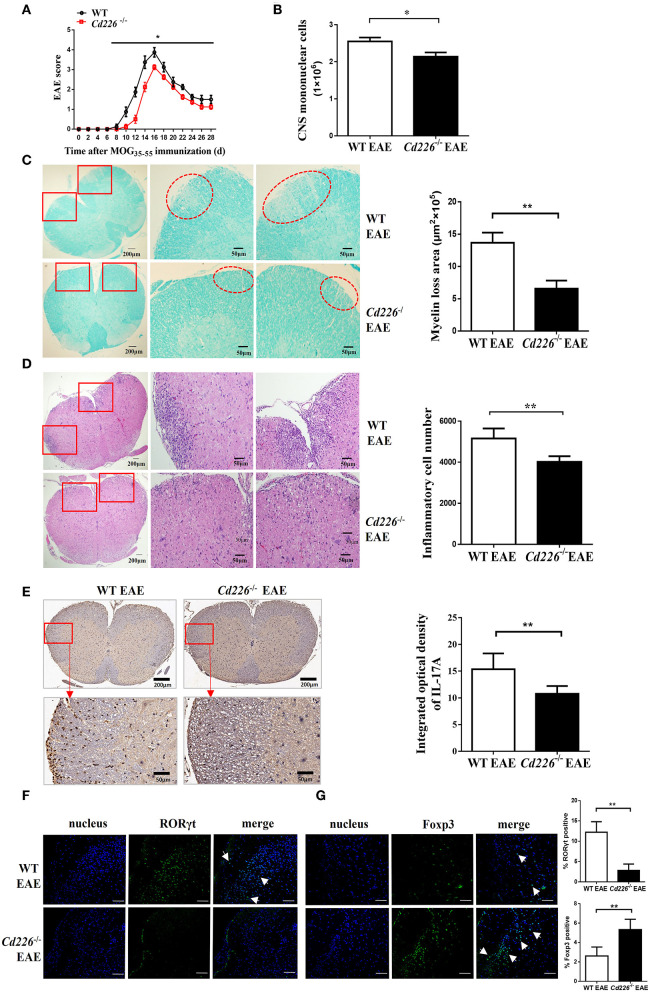
Cd226−/− mice are less susceptible to EAE, and lower levels of Th17 cells were infiltrated into the CNS of Cd226−/− mice during EAE. (A)
Cd226−/− and WT mice were immunized to induce EAE. The clinical score was monitored at the indicated days after immunization with MOG35−55 in CFA (n = 16). EAE scores were analyzed by a non-parametric Mann-Whiney U-test (two-tailed). The results represent eight independent experiments. (B) Mice were killed at the peak of EAE. Total mononuclear cells infiltrated in the CNS of WT and Cd226−/− mice were calculated (n = 6). (C) LFB staining of the lumbar region of the spinal cord (cross-sections) from WT and Cd226−/− mice at the peak of EAE (n = 6). Demyelination of representative spinal cord sections is indicated by loss of blue staining (scale bars indicate 200 and 50 μm for lower and higher magnification, respectively), and the total demyelinated area was measured with ImageJ. (D) Histological analysis of lymphocyte infiltration in the lumbar region of the spinal cord (cross-sections) of the indicated mice by H&E staining (scale bars indicate 200 and 50 μm for lower and higher magnification, respectively) (n = 6). (E) IL-17A expression in the lumbar region of the spinal cord (cross-sections) at days 15–18 post-immunization was detected by immunohistochemical staining (scale bars indicate 200 and 50 μm for lower and higher magnification, respectively) (n = 6). RORγt (F) and Foxp3 (G) expression in the brains of Cd226−/− mice and WT littermates at the peak of EAE were detected by immunofluorescence staining using RORγt (green) or Foxp3 (green) antibodies, respectively. Nuclei are shown in blue (DAPI) (3 cross-sections of brain per mouse, n = 6). The white arrowhead indicates Th17 cells or Tregs. Scale bar, 100 μm. The results represent three independent experiments (B–G). The data are presented as the mean ± SEM. nsP > 0.05, *P < 0.05, **P < 0.005.